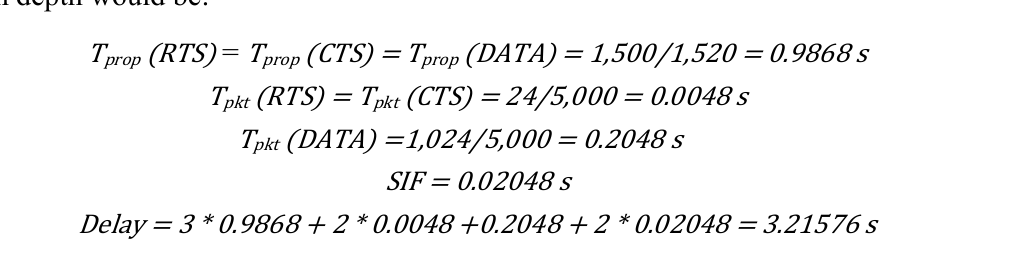
Figure 9. Average packet delay with different acoustic propagation